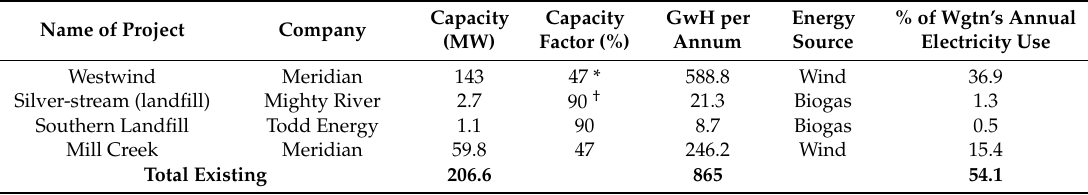
Table 2. Electricity Generation in